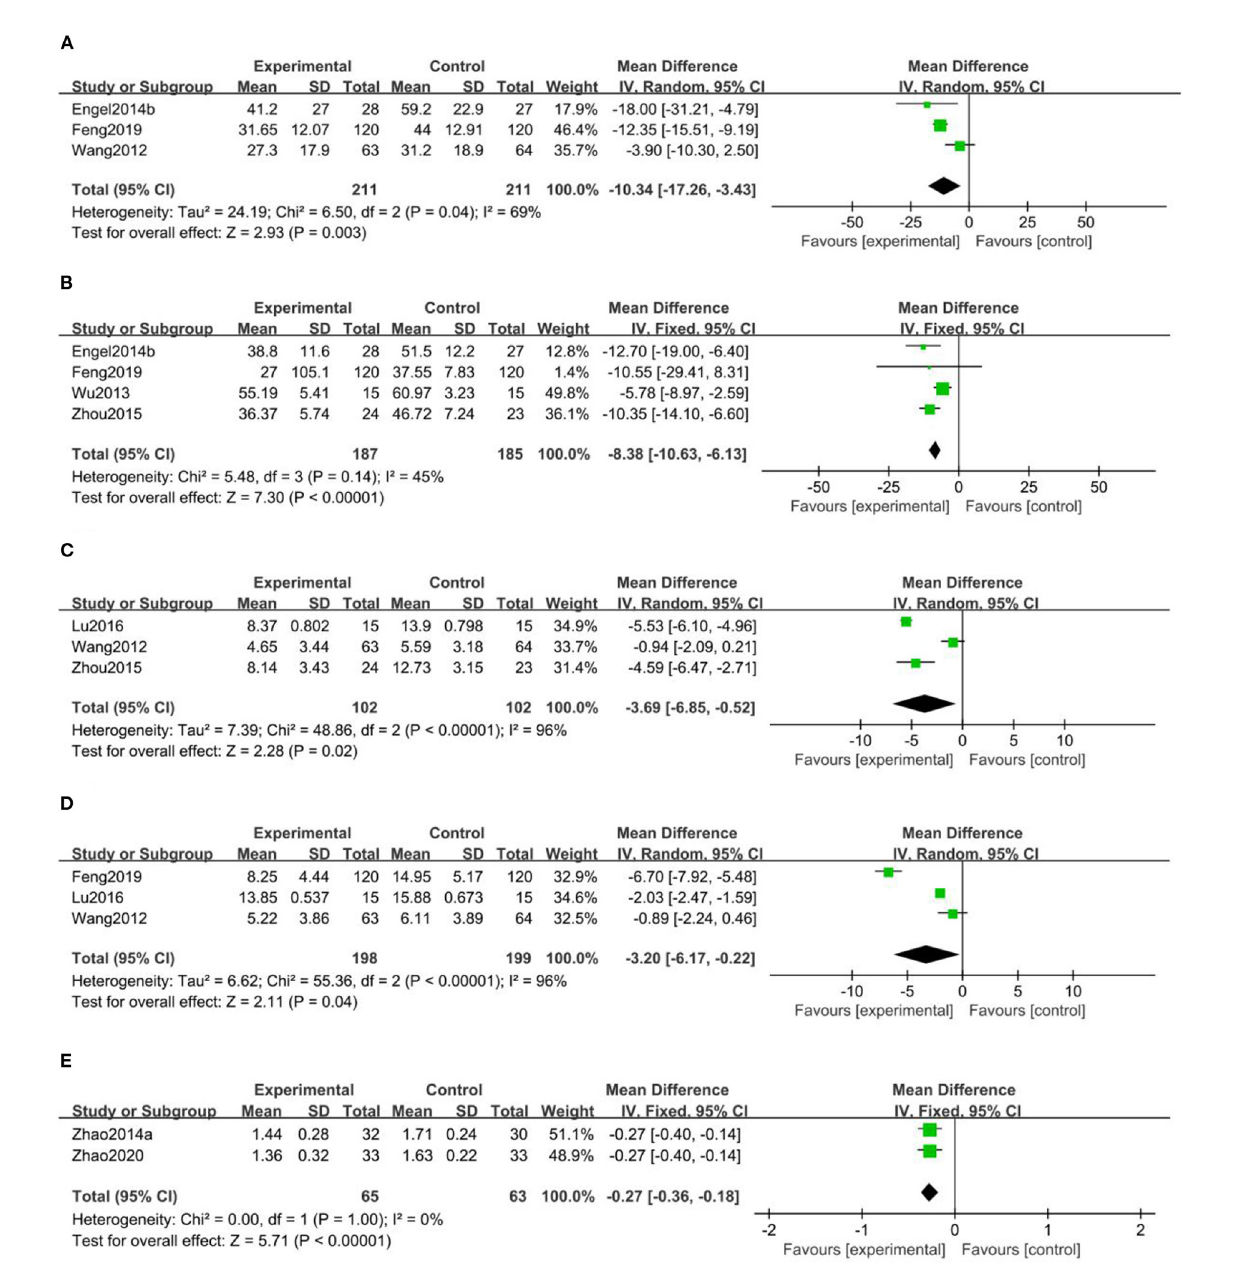
FIGURE2 Meta-analysis between acupuncture and pharmacotherapy or psychotherapy treatment. (A) The Clinician-Administered PTSD Scale score (CAPS) meta-analysis, (B) the PTSD Checklist-Civilian Version score (PCL-C) meta-analysis, (C) the Hamilton Depression Rating Scale score (HAMA) meta-analysis, (D) the Hamilton Anxiety Rating Scale score (HAMD) meta-analysis, (E) the Self-Reporting Inventory 90 somatization score (SCL-90 somatization)